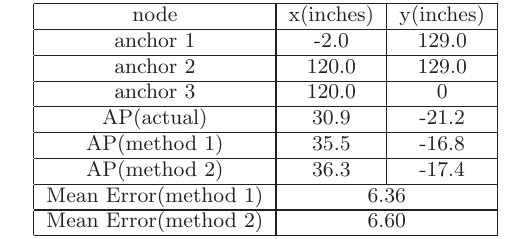
Outdoor Location Estimation Perfor- mances